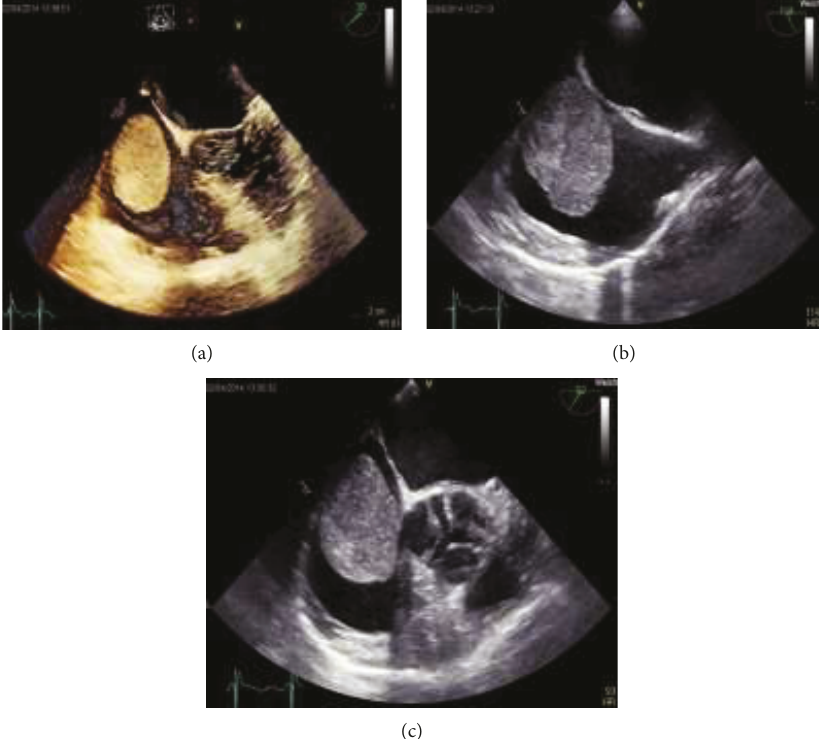
Figure 3: Large atrial mass in (a) the TEE 3D 4-chamber view, (b) the TEE 2D bicaval view, and (c) the TEE 2D short-axis view, conclusive for a mobile large atrial mass.